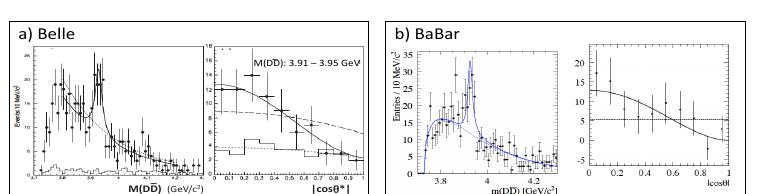
signal. right : dN / d | cos θ ∗ | c 2